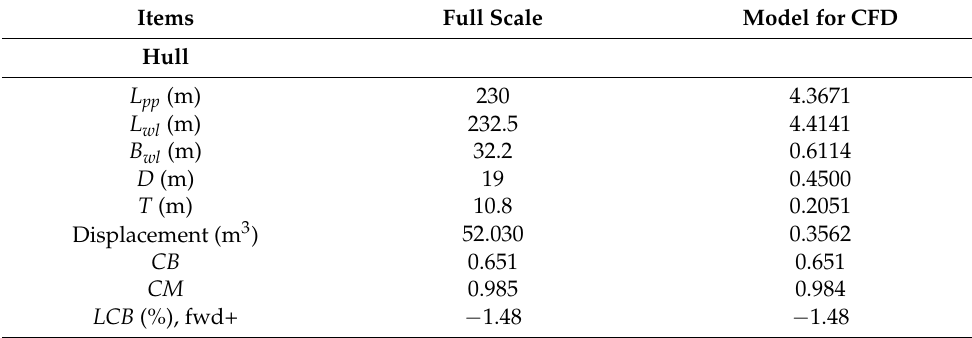
Table 2. Principal particulars of